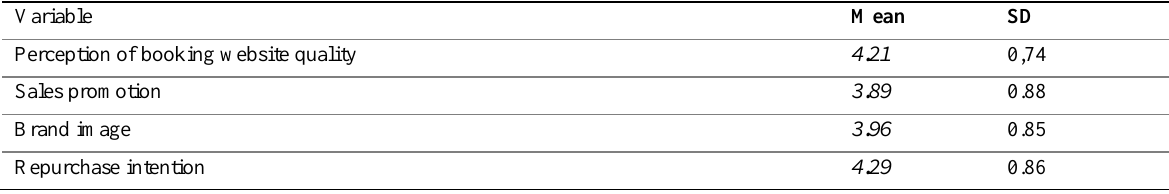
Table 2 : Descriptive Statistic and Correlation